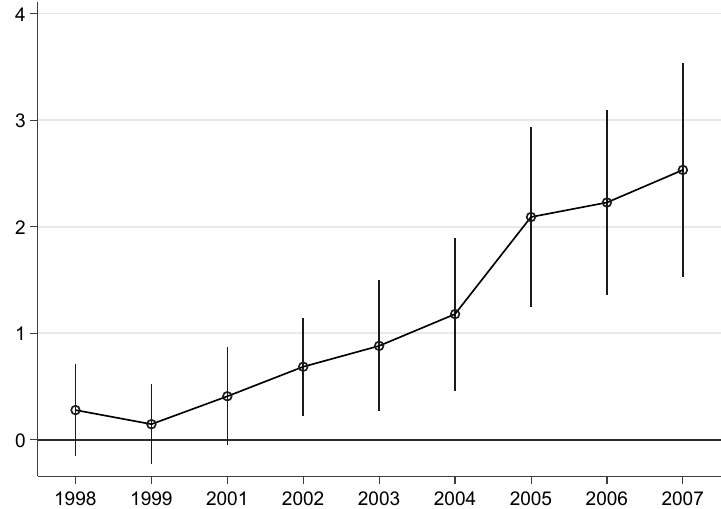
Figure 5. Parallel trend test.